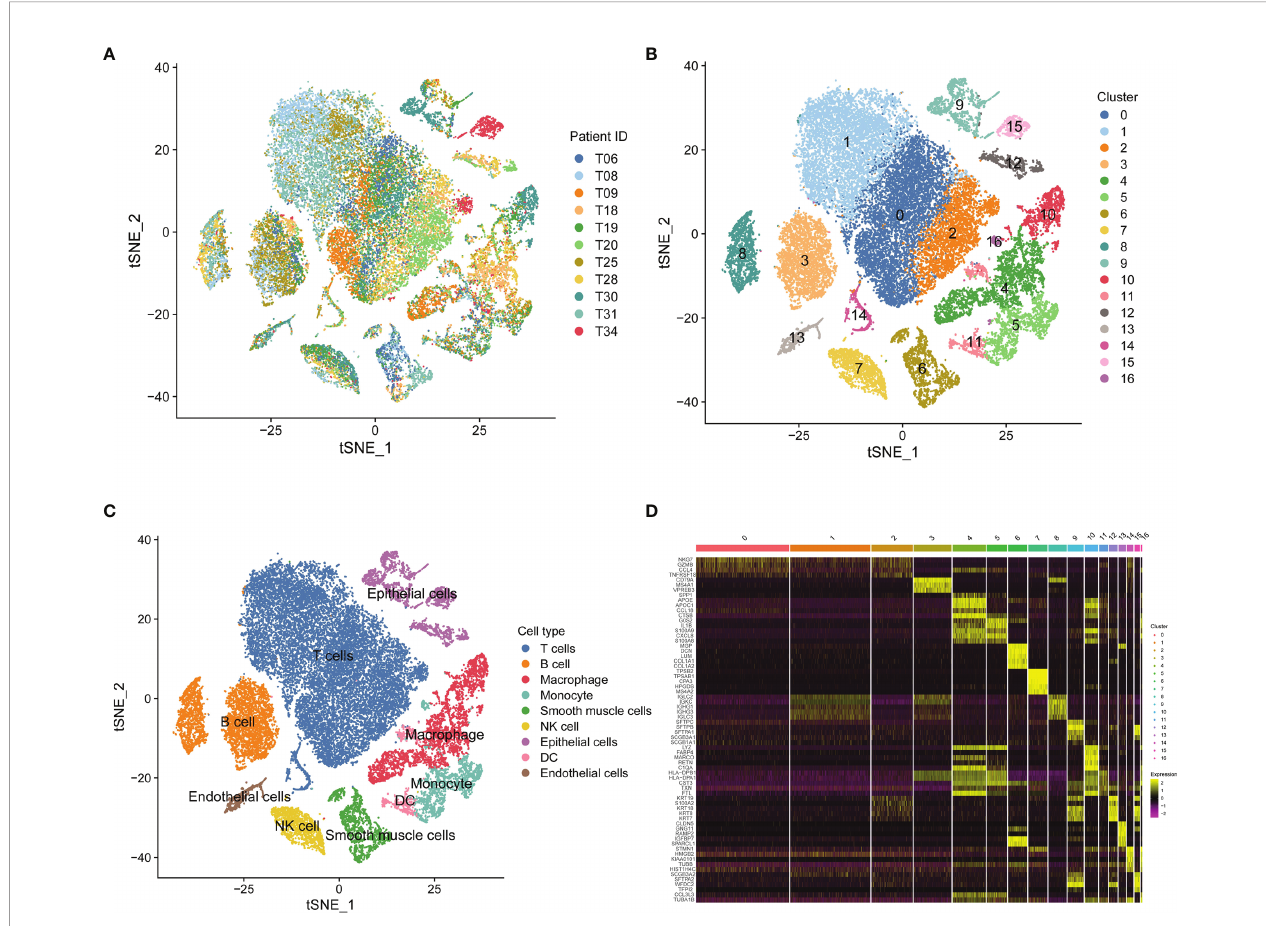
FIGURE 1 | Single-cell RNA-sequencing analysis identi fi es NK cell marker genes. (A) t-SNE plot of 45,149 cells from 11 primary LUAD samples. (B) t-SNE plot colored by various cell clusters. (C) The cell types identi fi ed by marker genes. (D) Heatmap showing the top 5 marker genes in each cell